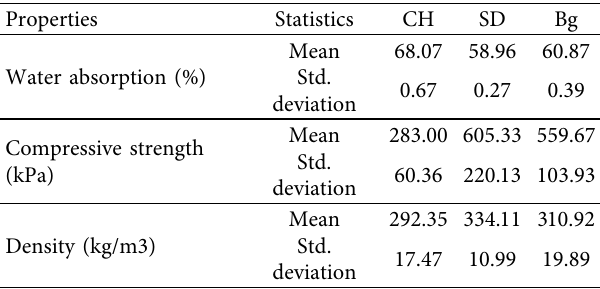
Table 4: The mean and standard deviation of Mycoblock at dif- ferent properties and